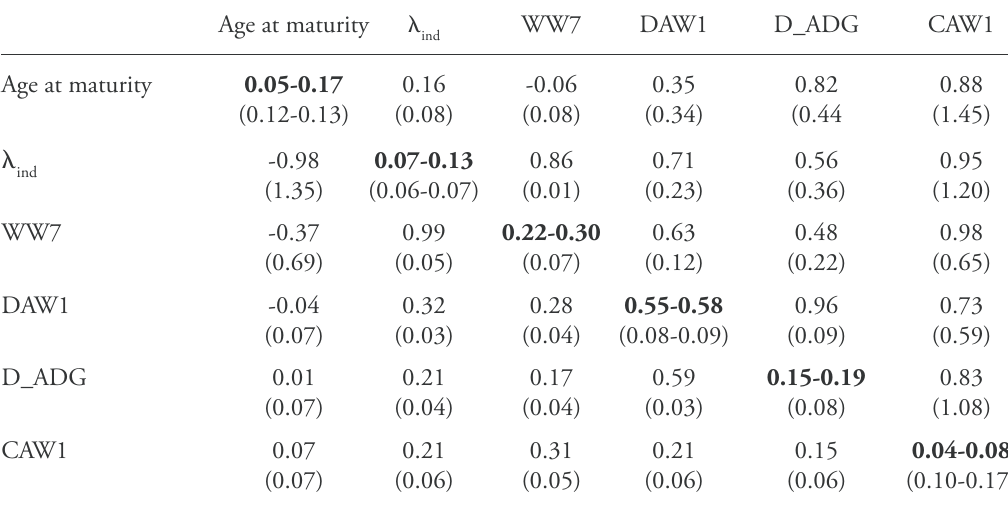
The standard errors are given in the parentheses under the